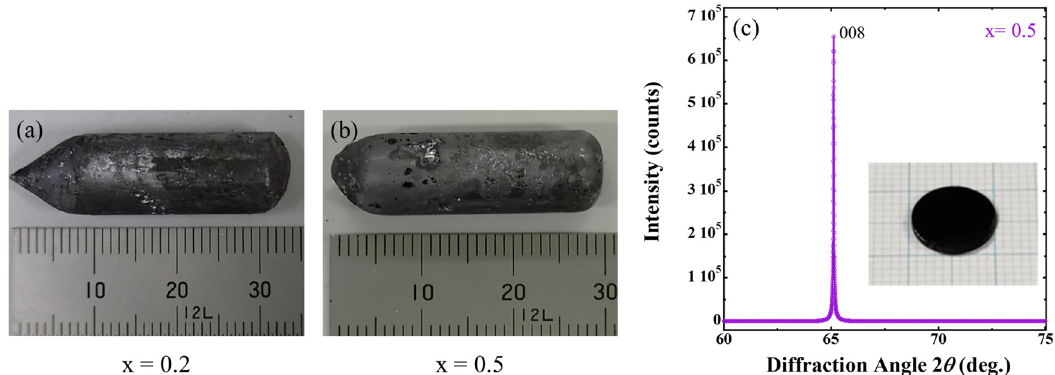
Figure 1: Photographs of CIGS single crystals with Ga content x = ( a ) 0.2 and ( b ) 0.5. ( c ) XRD of the cutting plane perpendicular to growth direction (= c - axis ) . Inset picture is CIGS wafer ( x = 0.5 )